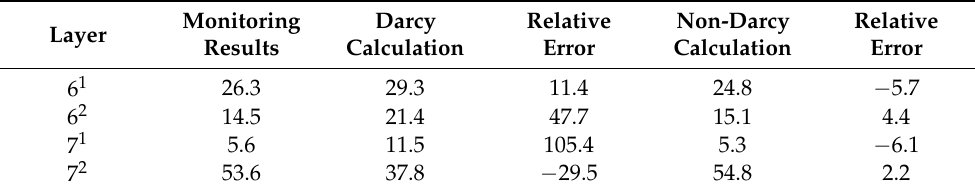
Table 2. Comparison of relative water absorption in Well Y4-6-15 (July 2009).